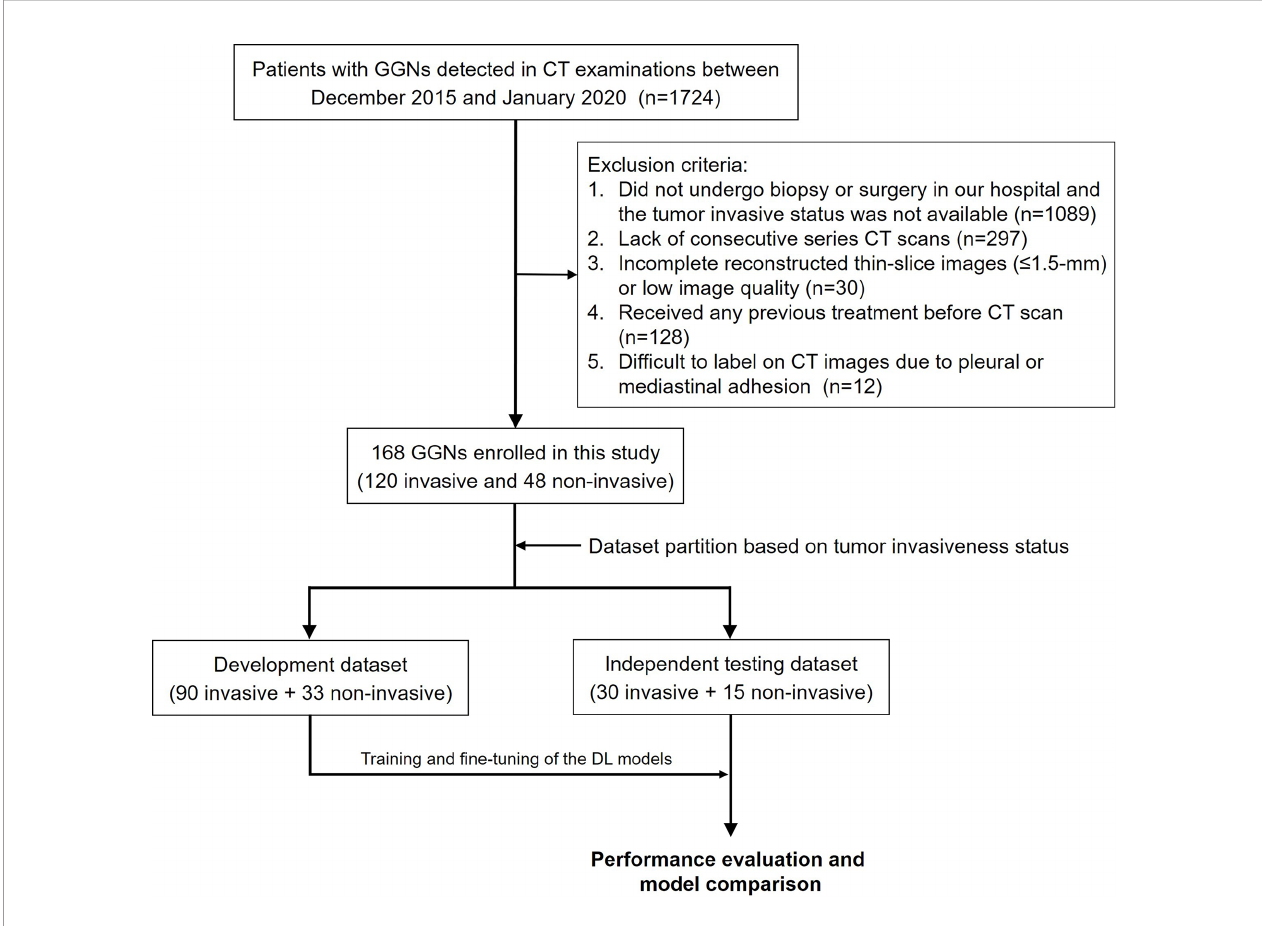
FIGURE 1 | Patient enrollment and study